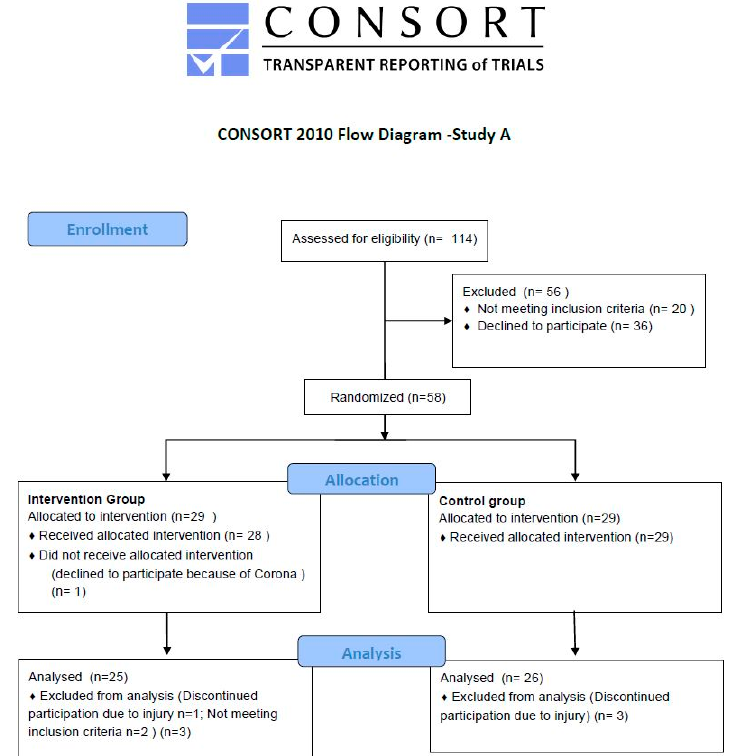
Figure 1. Consort fl ow diagram—Study A.